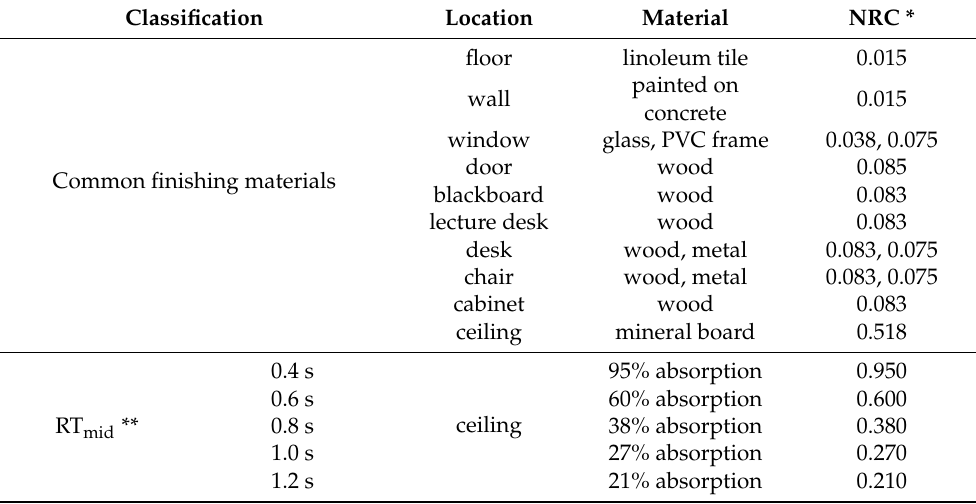
Table 6. Finishing materials for the classroom applied in the simulation. Classification